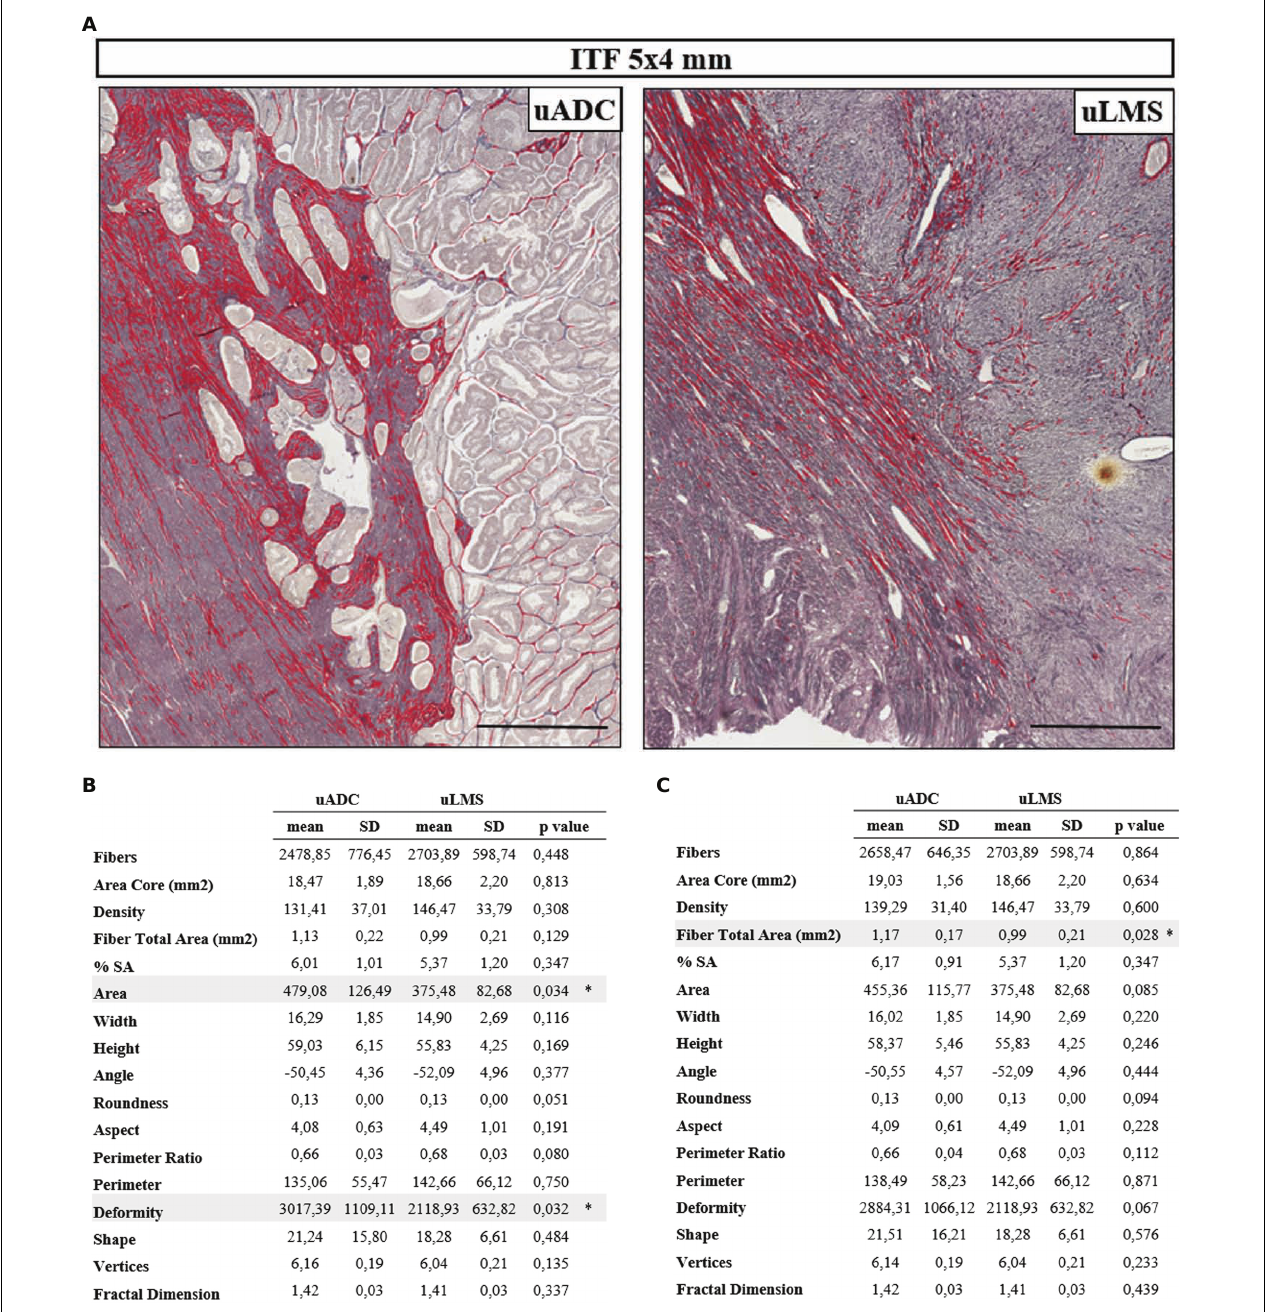
FIGURE 1 | Histomorphometric features of reticular fibers in uterine adenocarcinomas (uADC) and leiomyosarcomas (uLMS) in the 5 × 4-mm region of interest (ROI) are very similar at the invasive tumor front (ITF). (A) Representative image of fiber segmentation in 5 × 4-mm ITF ROIs in uADC and uLMS. Reticular fibers are highlighted in red. Scale bar represents 1 mm. (B) Comparison of morphometric parameters obtained after reticular fiber segmentation between uADC and uLMS 5 × 4-mm ITF ROIs. Fisher–Snedecor test and Student T -test were applied for statistical comparison. Mean, standard deviation (SD), p -Values, and significance ( ∗ < 0.05) are shown. Total fibers, area of the core, and sum of the total area of the fibers were measured to calculate the density (number of fibers/mm 2 ) and percentage of the stained area (% SA). Area in µ m 2 . Length and width in µ m. (C) The same comparison as in B with more restrictive criteria for case selection.